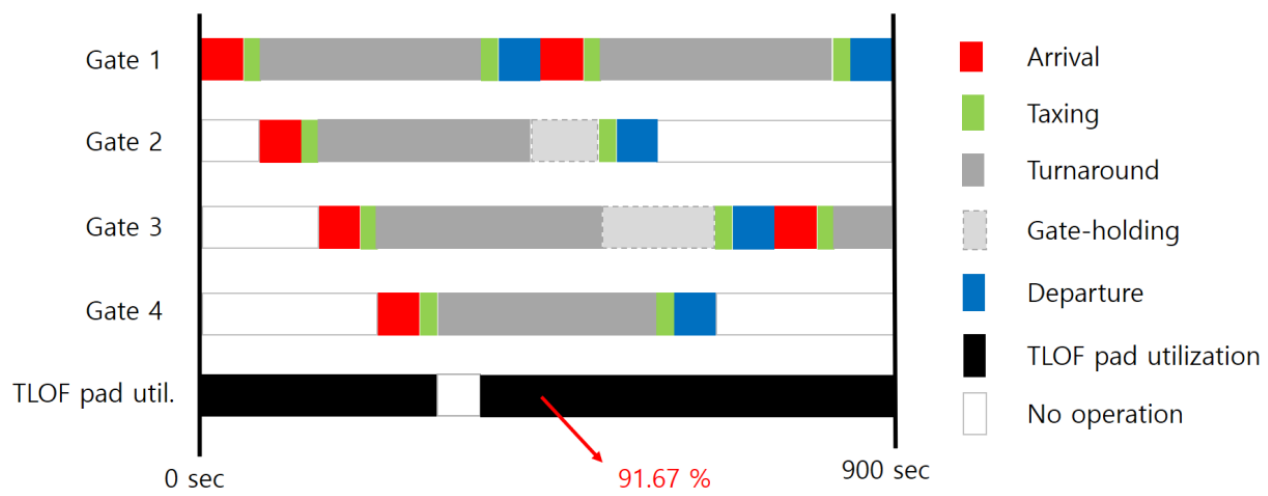
Figure 25. TLOF pad utilization rate (one TLOF pad, four gates). Table 3. Variables for capacity determination algorithm.